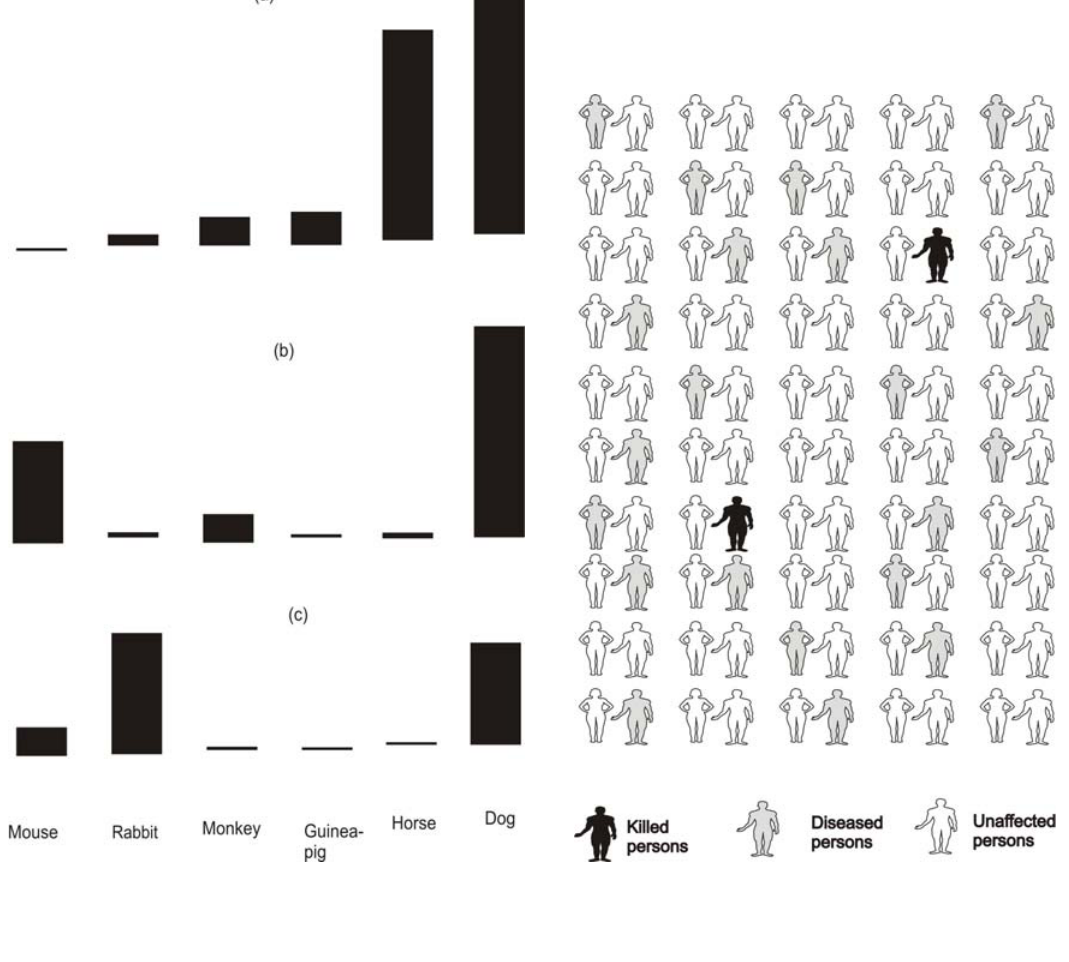
FIGURE 3. Variations in the degree of constitutional immunity to (a) anthrax, (b) botulinic toxin, and (c) tetanic toxin in a selection of vertebrata species.